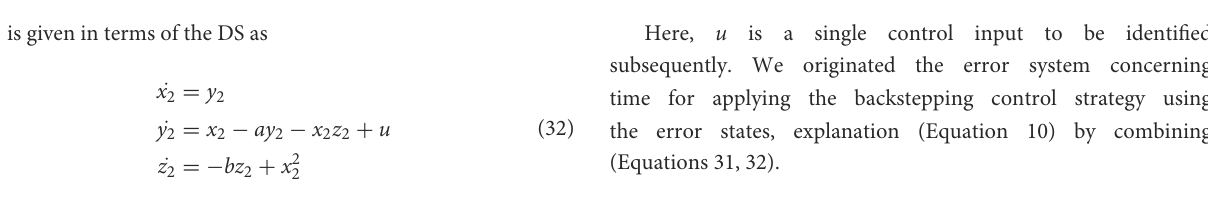
is given in terms of the DS